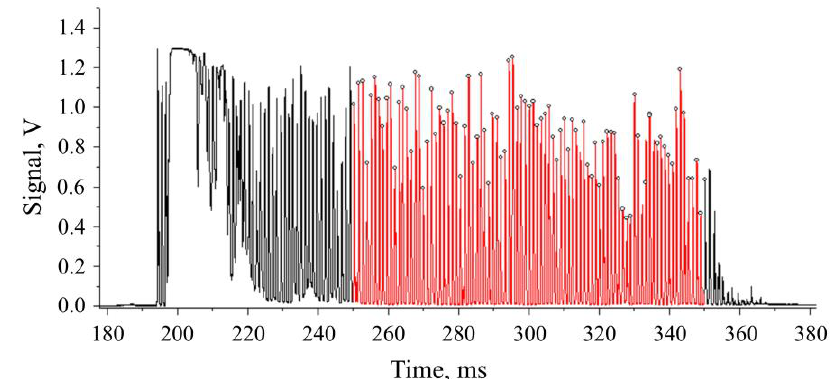
Figure 16. An example of the IS record during RDE